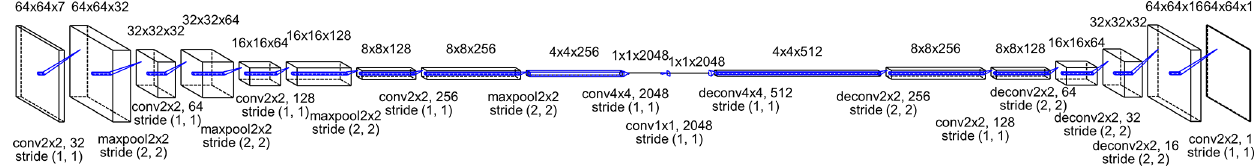
Figure 3. The developed deep learning model for precipitation forecasting.